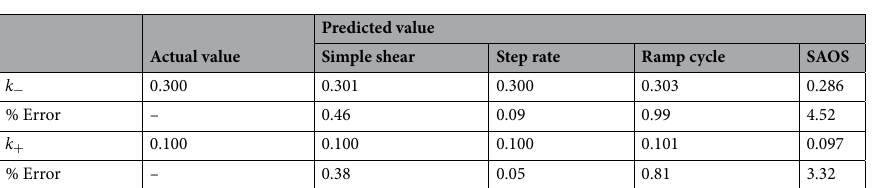
Table 2. RhINNs-predicted values for k + and k − in different shear rate protocols. For all cases G = 30 [ Pa ] , σ